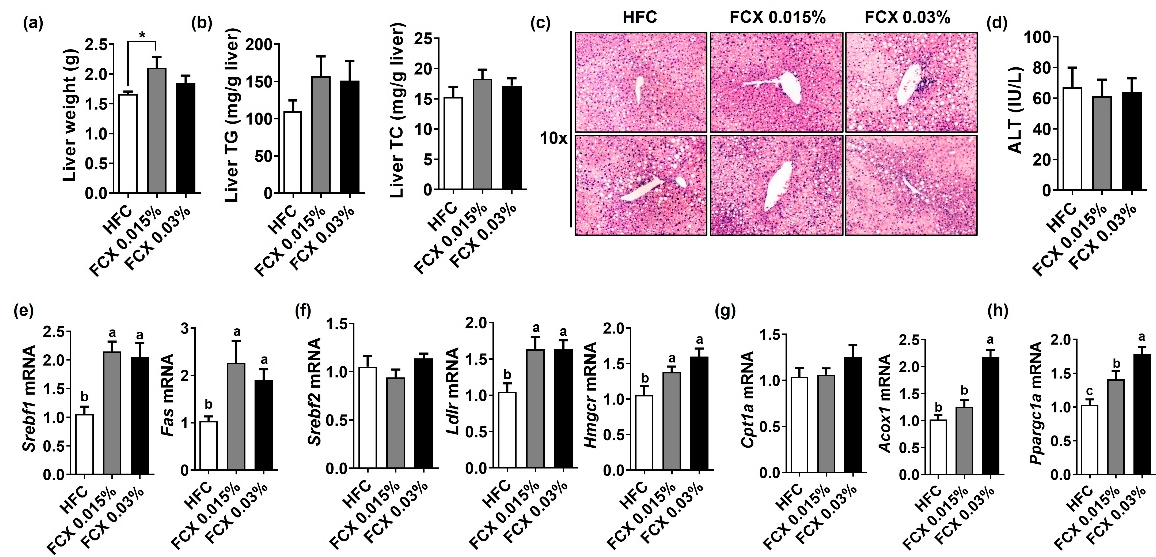
Figure 2. Effect of FCX on liver steatosis in DIO mice fed HFC control, FCX 0.015%, or FCX 0.03% for 12 weeks. ( a ) Liver weight. ( b ) Liver TG and TC levels. n = 9–11 per group. ( c ) Liver sections stained with H&E. n = 8 per group. ( d ) Serum ALT levels. n = 8–11 per group. Hepatic mRNA levels of ( e ) lipogenic genes, ( f ) cholesterol metabolism genes, ( g ) β -oxidation genes, and ( h ) mitochondrial biogenesis-related gene. n = 9–11 per group. Mean ± SEM. Bars without sharing the same letter are significantly different ( p < 0.05). * p < 0.05 between two groups.